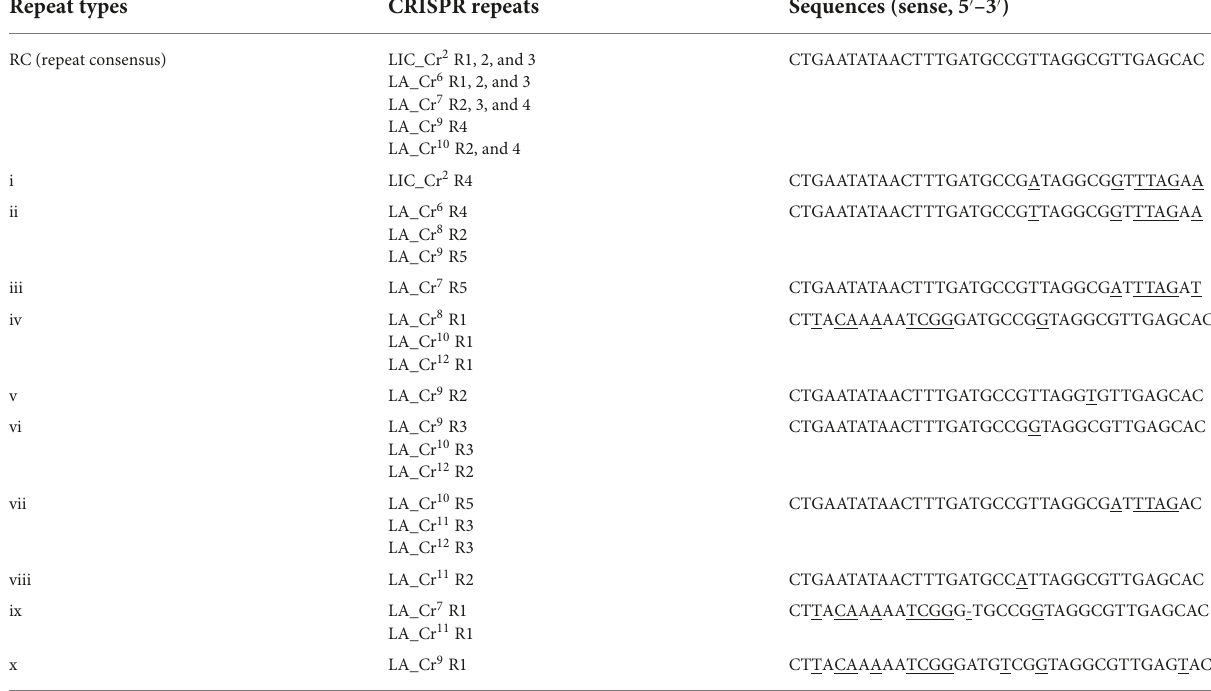
TABLE 2 CRISPR I-B repeats variants in L. interrogans svs. Copenhageni and Lai (in redefined CRISPR locus). Repeat